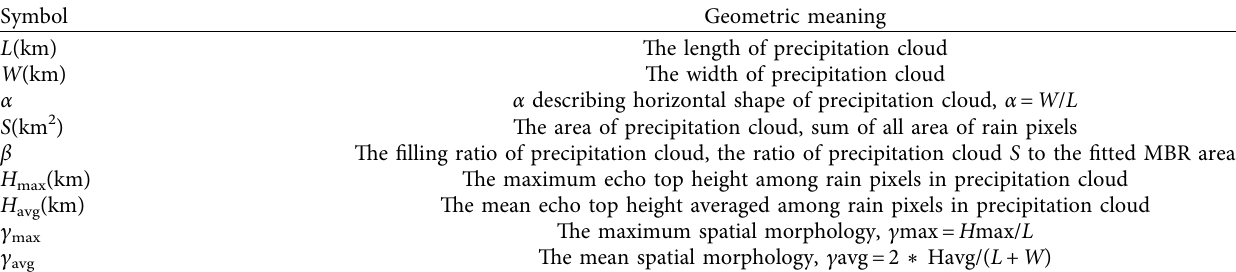
Figure 1: Topographic map of the Tibetan Plateau (The red line represents the 3000-meter Table 1: The definition of geometric parameters of precipitation clouds.